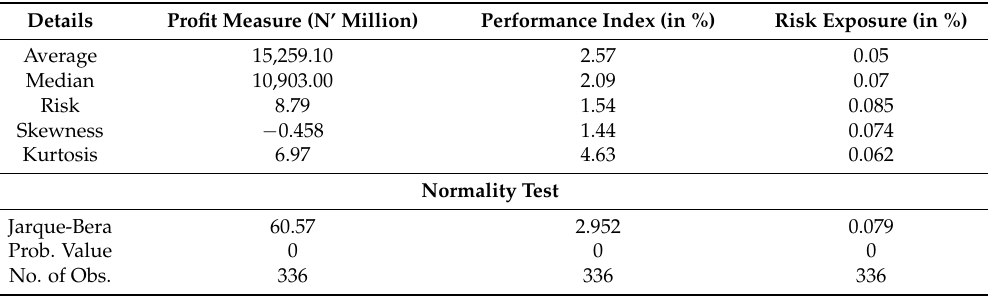
Table 2. Descriptive